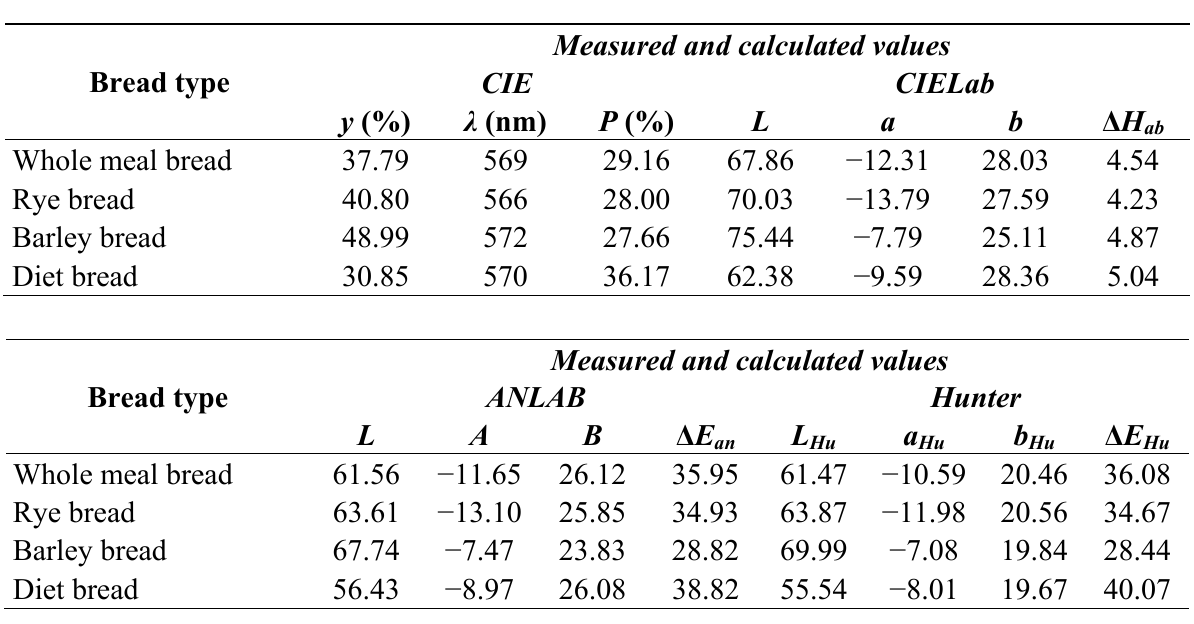
Table 1. Results of instrumental color determination of different kinds of bread immediately after production.